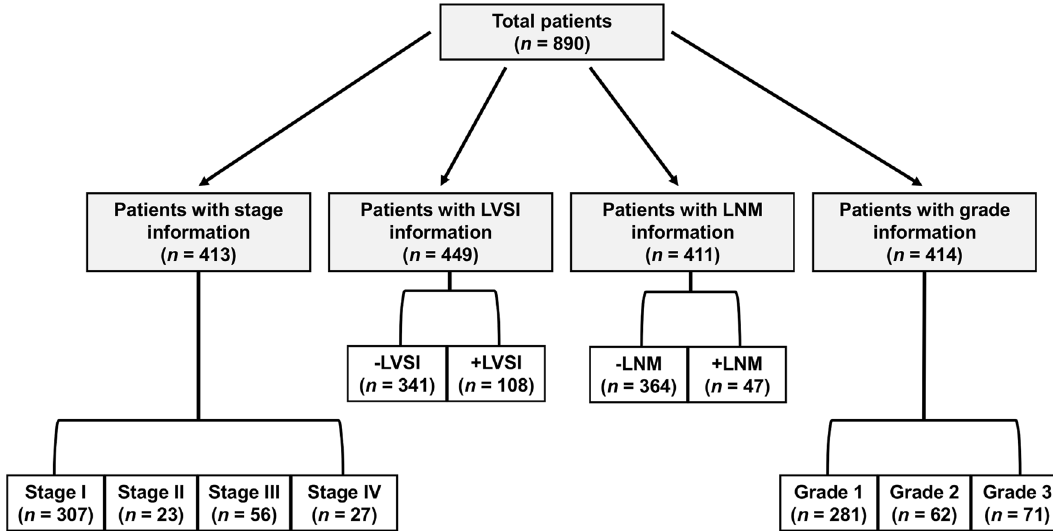
Figure 1. Classification of patient population based on outcome measures. Patients within each group are not mutually exclusive, with 342 patients having information available for each of the four groups.